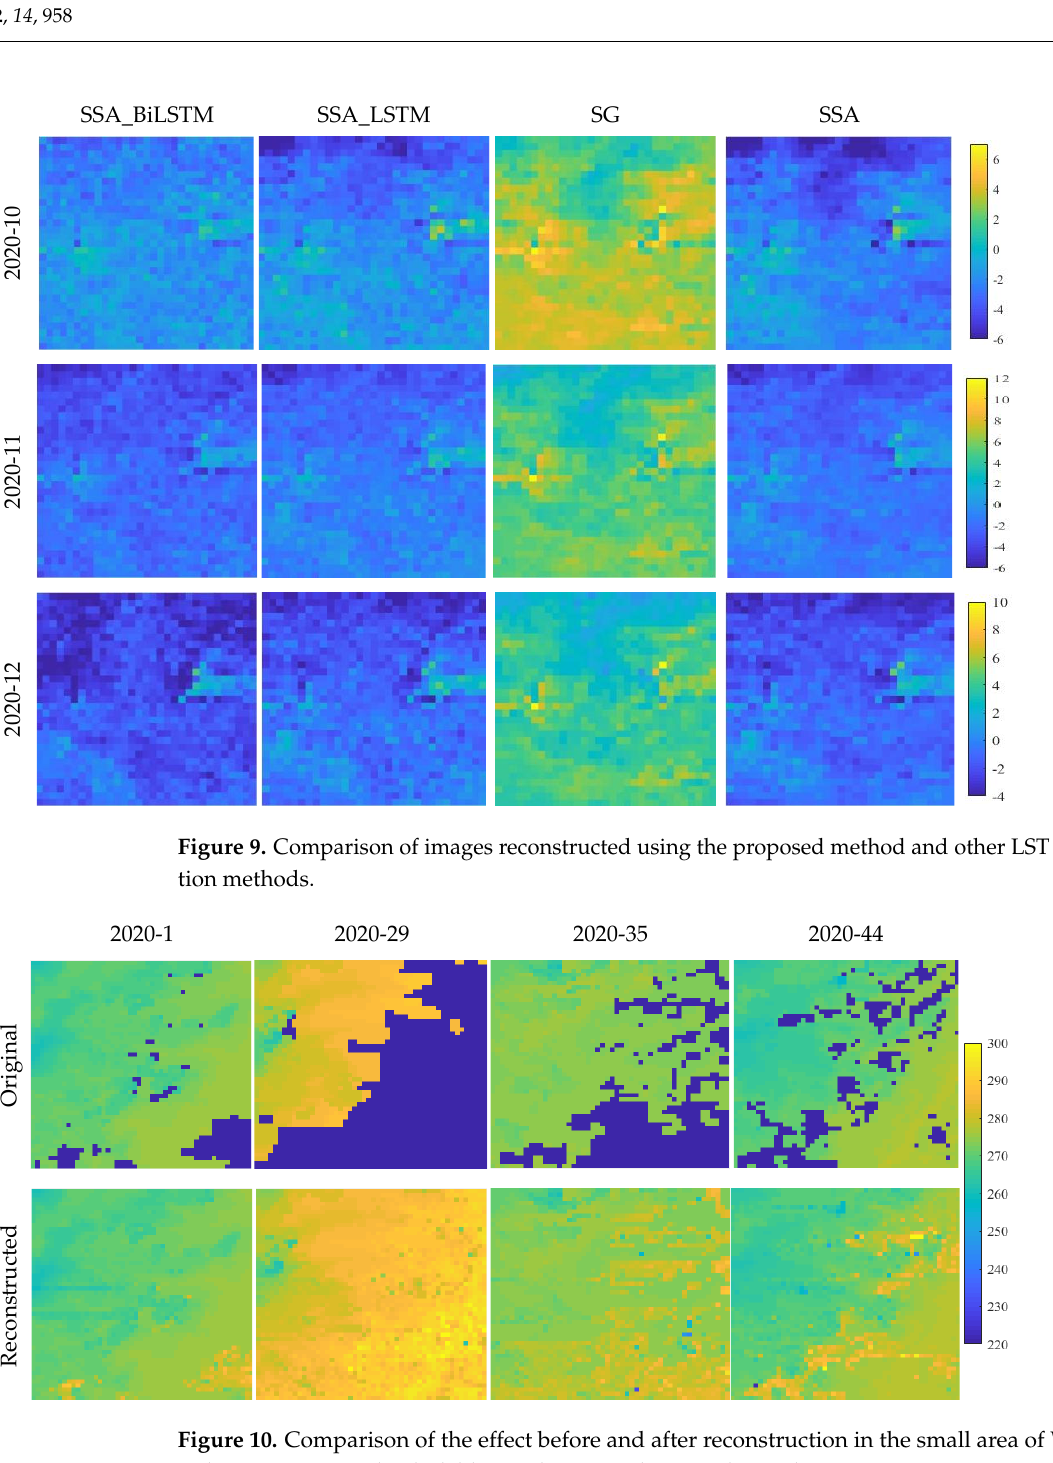
Figure 8. Comparison between the images reconstructed using different methods. The red blocks in the charts above represent the areas where the missing data are reconstructed. 2020-10, 2020-11 and